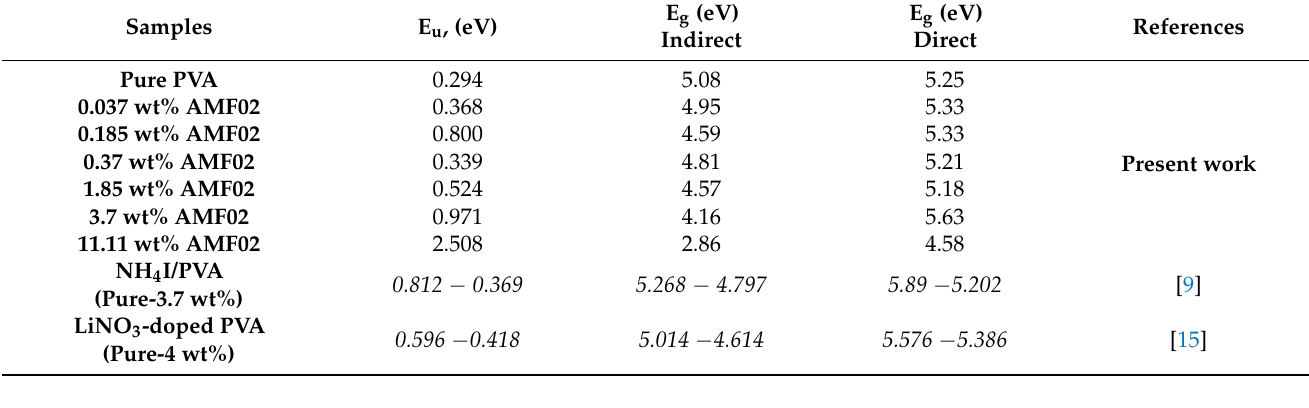
Table 1. The band tails Urbach’s energy, the indirect and direct bandgap for pure PVA film, and its AMF02 salt-doped PVA novel PCCEFs.